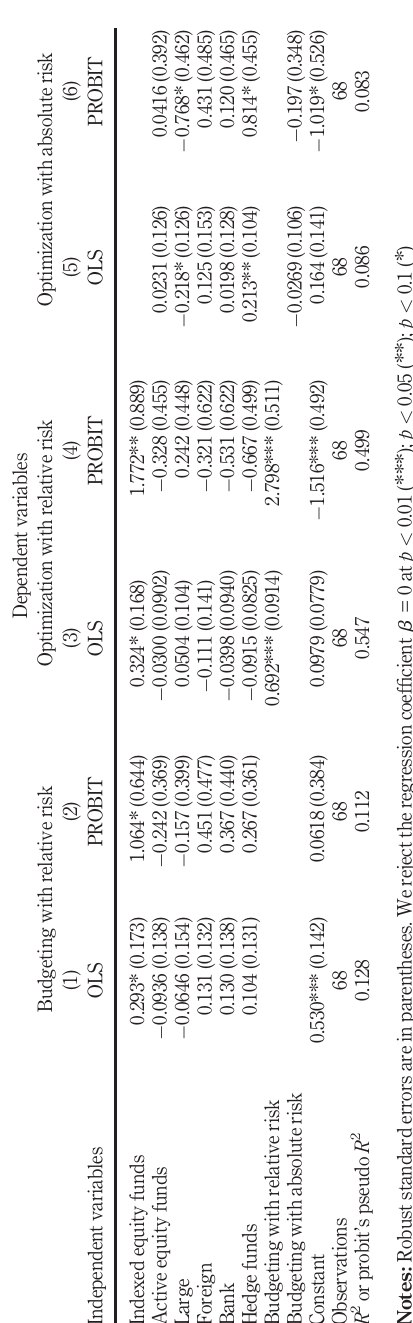
Table VII. Results of OLS and probit